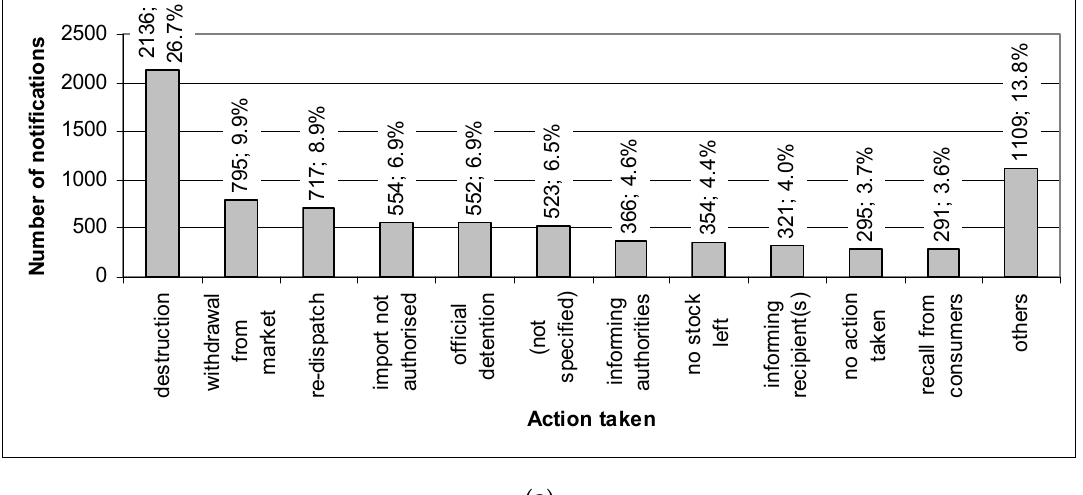
Figure 2. Number and percentage of notifications on pesticide residues in the RASFF by variable. The border rejections accounted for nearly half of all notifications (48.4%), information notifications for 36.6% and alerts only for 15.0% (Figure 2a). Notifications were related mainly to fruits and vegetables (67.6%), as well as herbs and spices (10.0%), cocoa and cocoa preparations, coffee and tea (7.8%) and nuts, nut products and seeds (5.3%) (Figure 2b). The reported products originated mainly from India (18.1%) and Turkey (17.6%), as well as from China (7.8%), Thailand (6.2%), Egypt (5.8%) and Italy (3.7%) (Figure 2c). They were notified by Germany (13.3%), Bulgaria (12.1%), the United Kingdom (10.2%), the Netherlands (9.1%), France (8.2%) and Italy (8.0%) (Figure 2d). The notifications were based on border control, after which the consignment was detained (47.2%), as well as official controls in the market (26.4%) and the company’s own checks (10.9%) (Figure 2e). Products were not placed on the market (29.0%), were not distributed (18.6%) or were distributed to other countries (13.2%) (Figure 2f) and the most common actions taken against them were destruction (26.7%), withdrawal from the market (9.9%) and re-dispatch (8.9%) (Figure